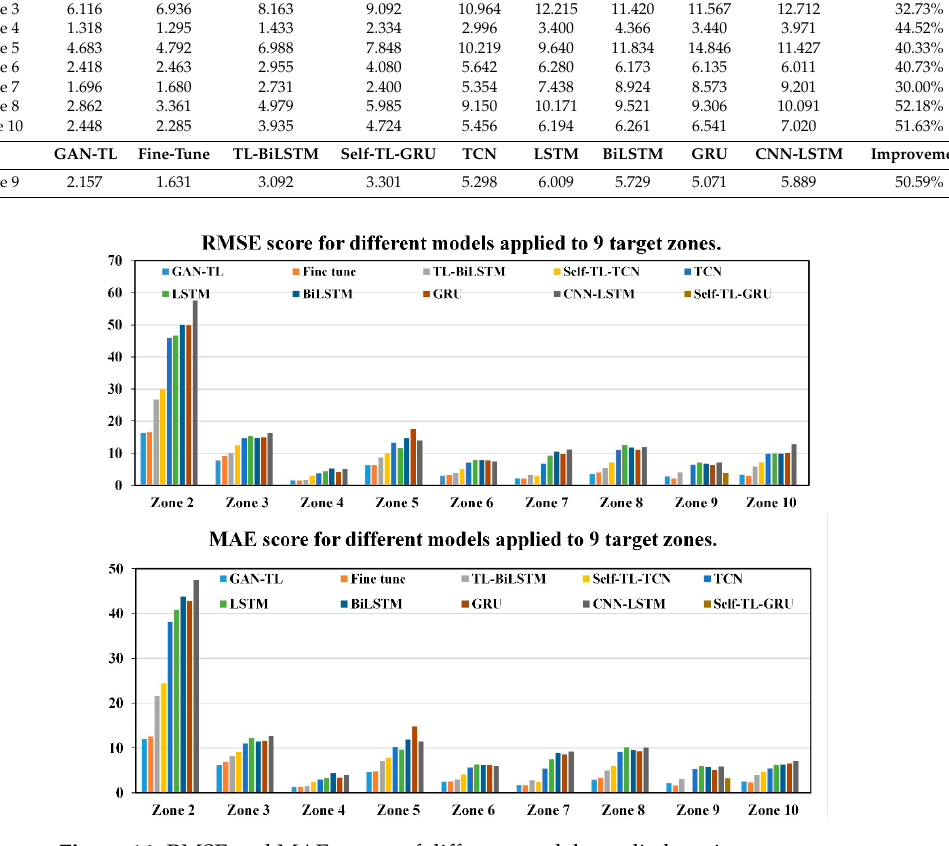
Table 10. The similarity between the generated features and the source domain, as well as the similarity between the original features and the source domain.